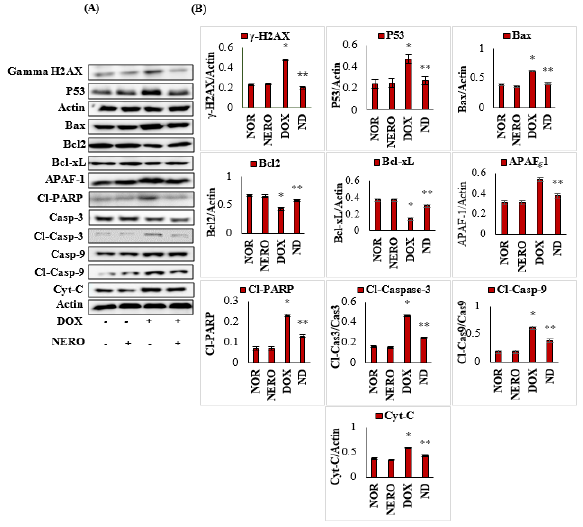
Figure 5. ( A , B ). Representative images of Western immunoblot analysis and densitometry for γ -H2AX, P53, Bax, Bcl2, Bcl-xL, active caspase-3, active caspase-9, APAF-1, cleaved PARP, and cytochrome-C. The values are expressed as the mean ± SEM ( n = 3); columns do not share a common symbol (*, **) and differ significantly with each other (* p < 0.05 vs. normal control, ** p < 0.05 vs. DOX control). H2AX—H2A histone family member X; Bcl-2—B-cell lymphoma 2; Bax—Bcl2-associated-X- protein; Bcl-xL—B-cell lymphoma extra-large; P53—tumor protein; APAF-1—apoptotic protease activating factor 1; Cyt-C—cytochrome-C; CL-PARP-cleaved poly (ADP-ribose) polymerase; Casp-3— caspase 3; Cl-Casp-3—cleaved caspase-3; Casp-9—caspase 9; Cl-Casp-9—cleaved caspase-9; NOR— normal; NERO—nerolidol; DOX—doxorubicin; ND—rats administered with a single intraperitoneal dose of DOX and orally treated with